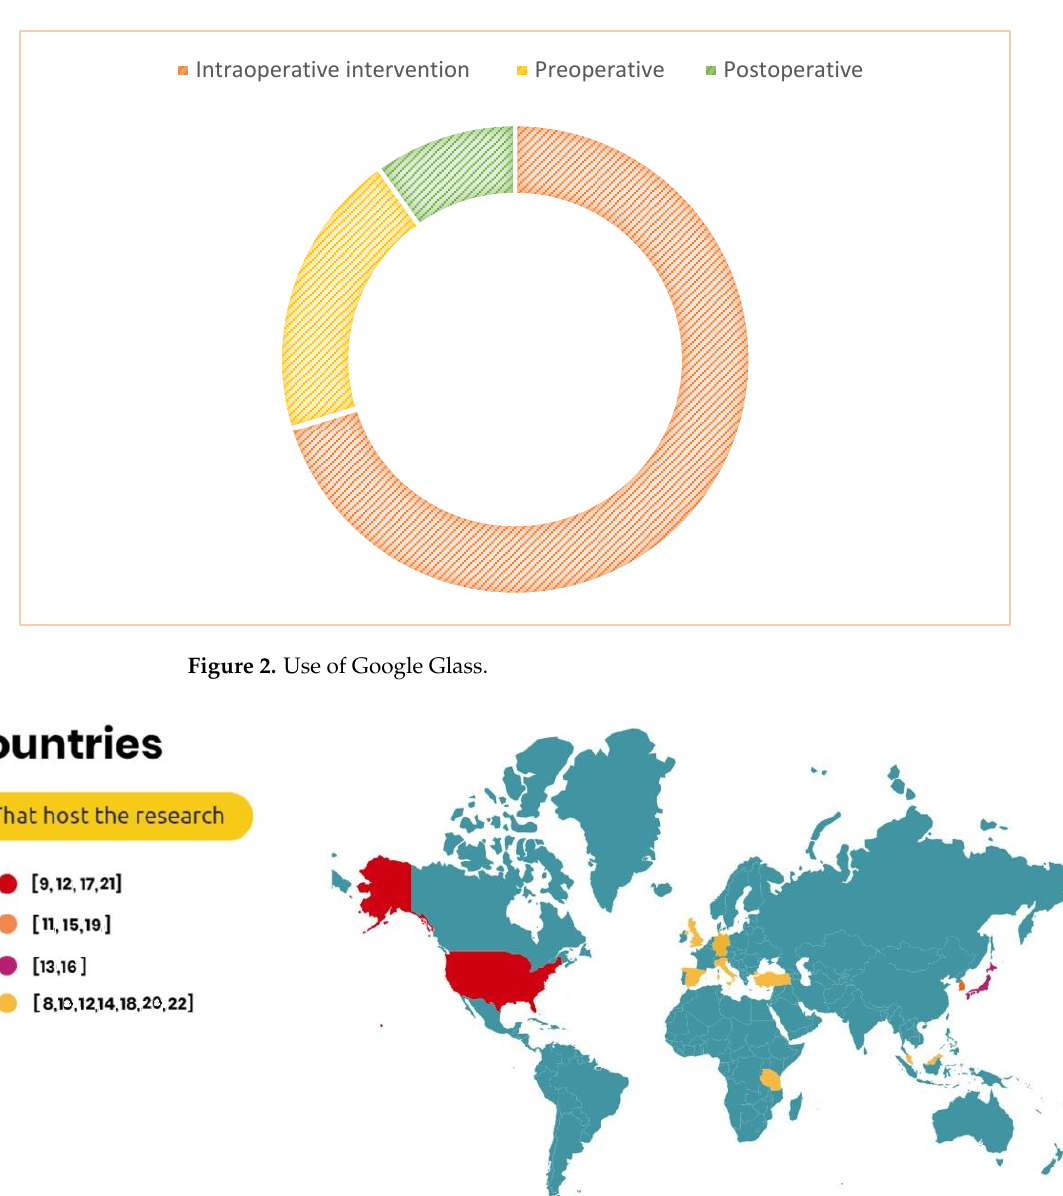
Table 1. The summary of the selected studies that focus on Google Glass applications in the healthcare field.